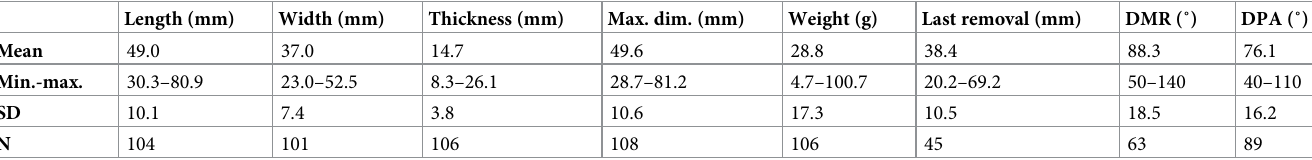
Table 12. Summary of descriptive statistics for Tweefontein Nubian cores. Length